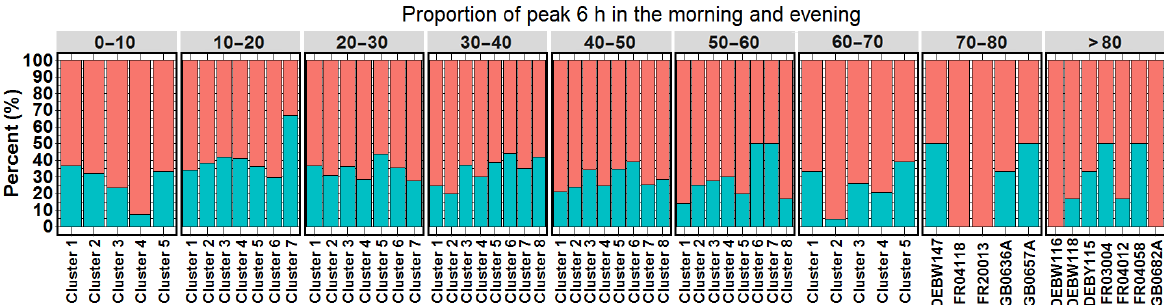
Figure 7. Proportion of the 6h of the day that make the largest contribution to 2010–2014 average annual NO 2 concentrations (NO 2AA ) that occurred in the morning (before 12:00, blue), and in the afternoon/evening (after 12:00, red), for sites with 2010–2014 NO 2AA in 10µgm − 3 bins, and separated by clusters demarcating distinct variation in monthly, hour of day, and hourly NO 2 concentration bin contributions to NO 2AA